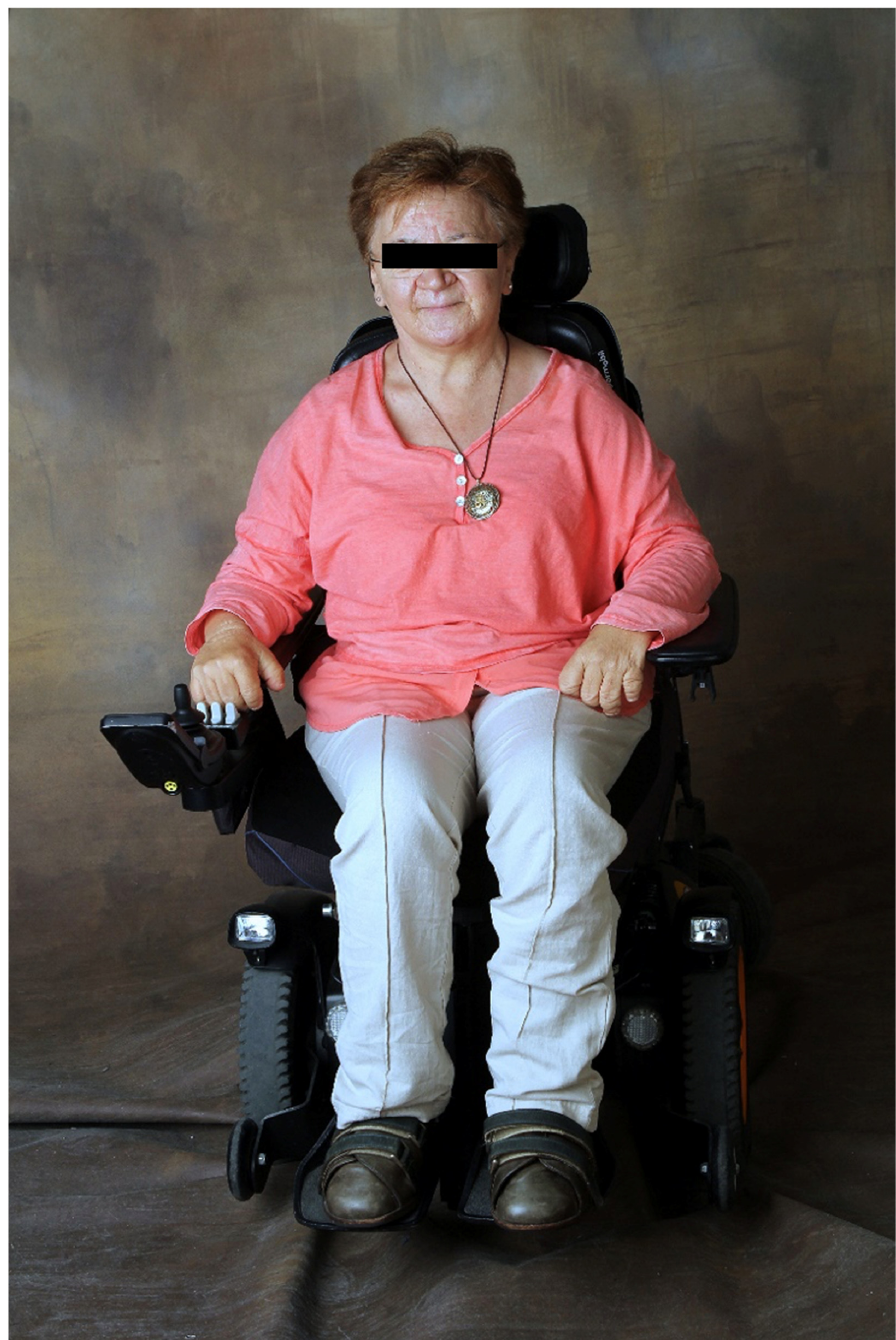
Figure 1. Current photograph of the patient.